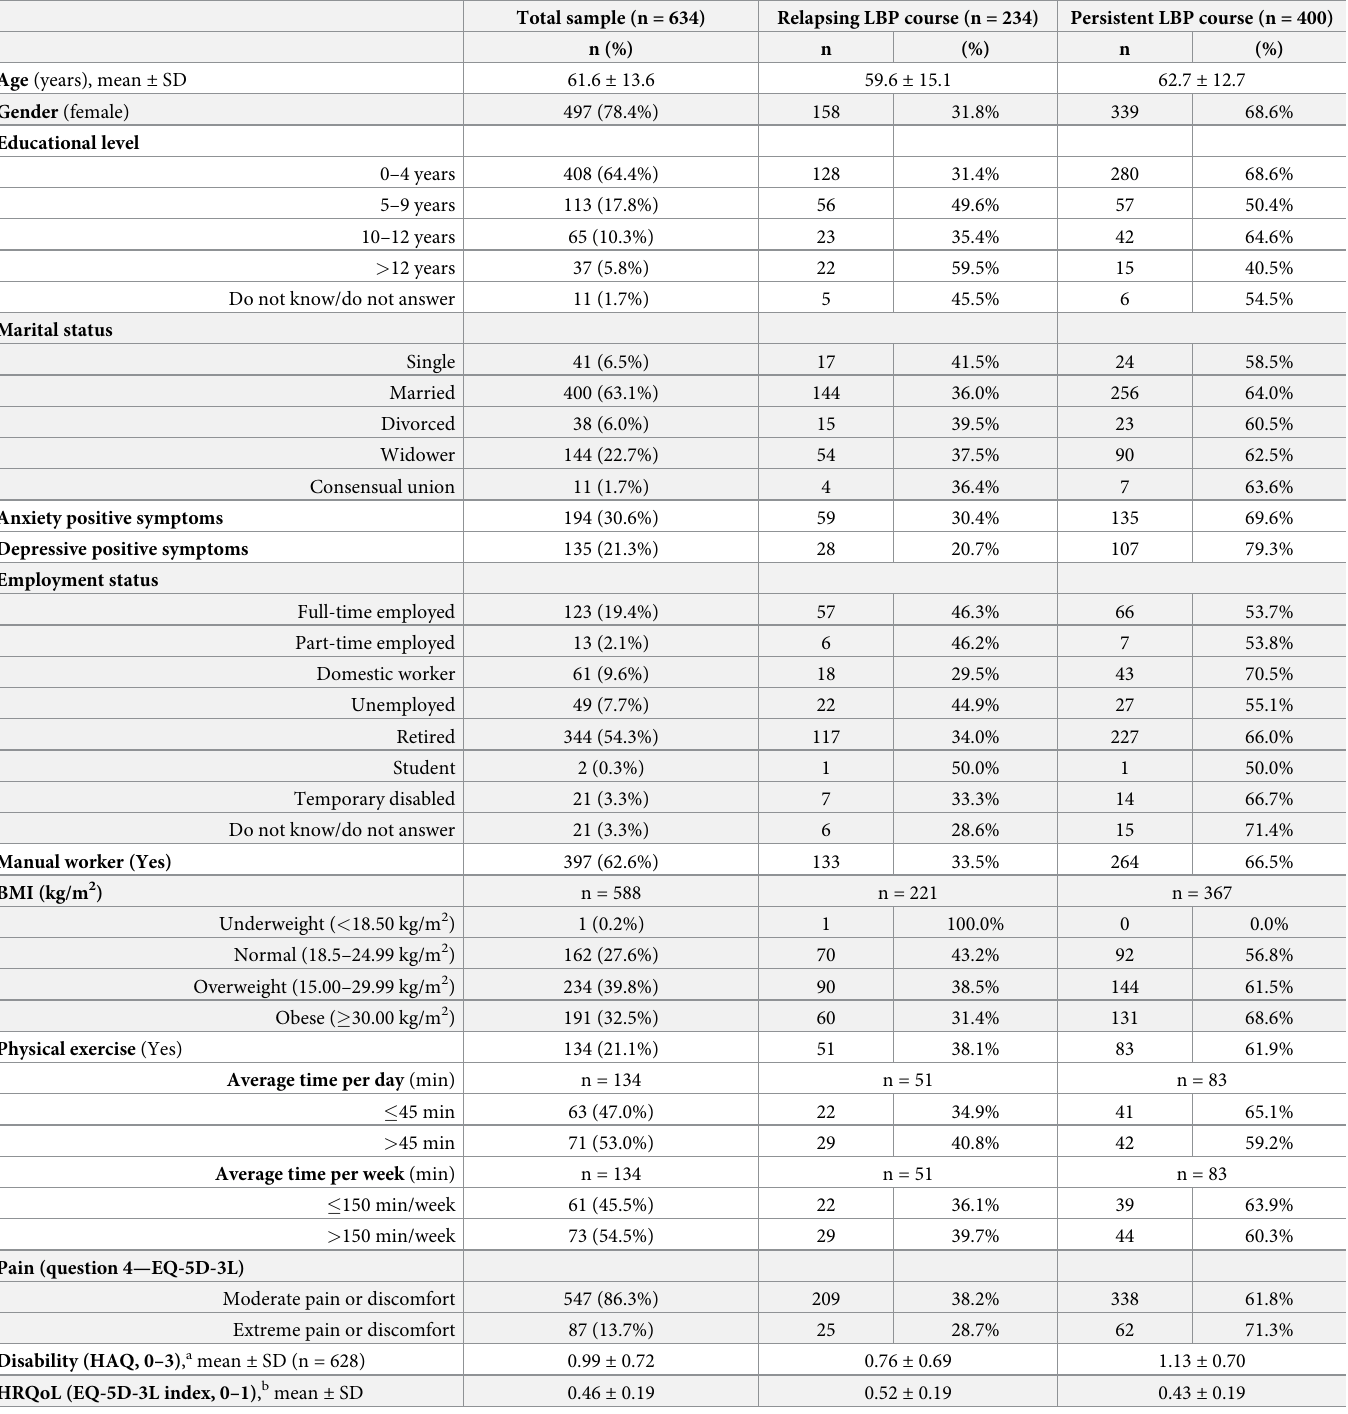
Table 1. Socio-demographic characteristics of the participants at baseline. Total sample and groups (n =